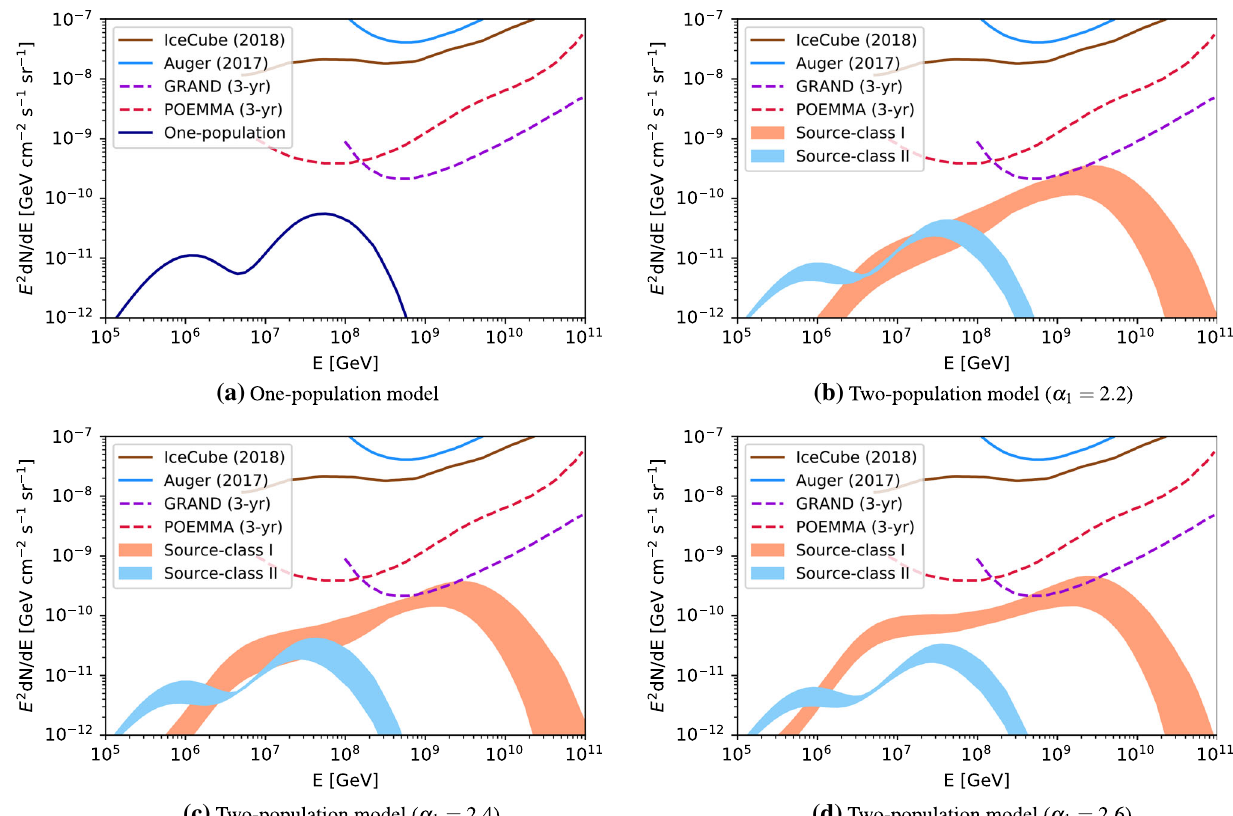
Fig. 2 The all-flavor cosmogenic neutrino fluxes for one-population and two-population models (without cosmological evolutions) along with the sensitivity of currently operating and future neutrino detectors.